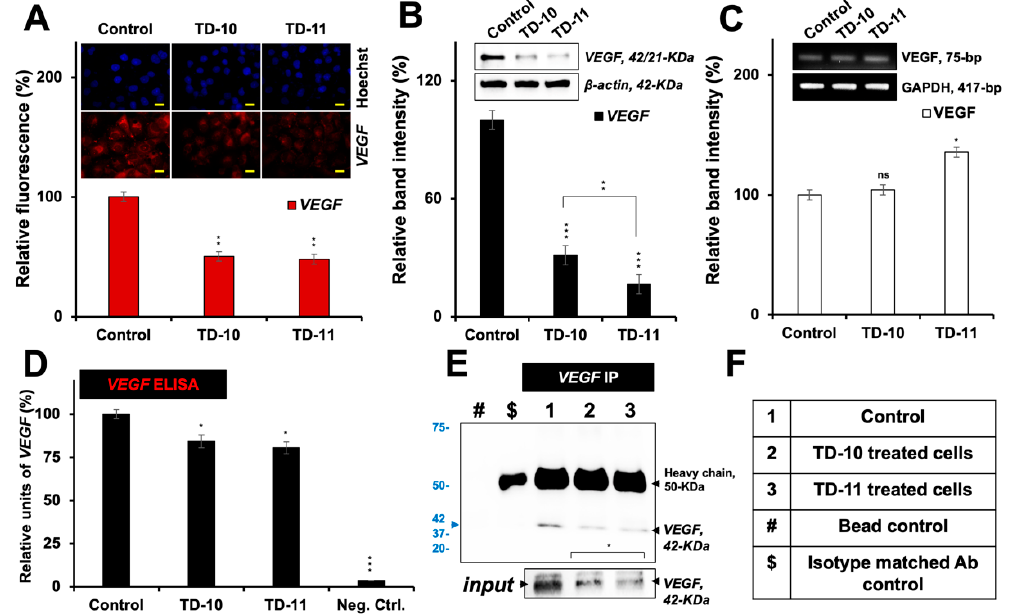
Figure 4. VEGF analyses in Panc-1 cells treated with TD-10 and TD-11. Immunostaining ( A ), Western blotting ( B ) and RT-PCR ( C ) showed downregulation of VEGF expression at the protein ( A , B ) and mRNA ( C ) levels, respectively. ELISA ( D ) and immunoprecipitation ( E , F ) assays showed downregulation of secreted VEGF expression in the surrounding culture medium. Scale 20 µ m. Statistical significance was defined as p -values (*) where ns, * < 0.05, ** < 0.01 and *** < 0.001 represent not significant, significant, very significant and highly significant, respectively.